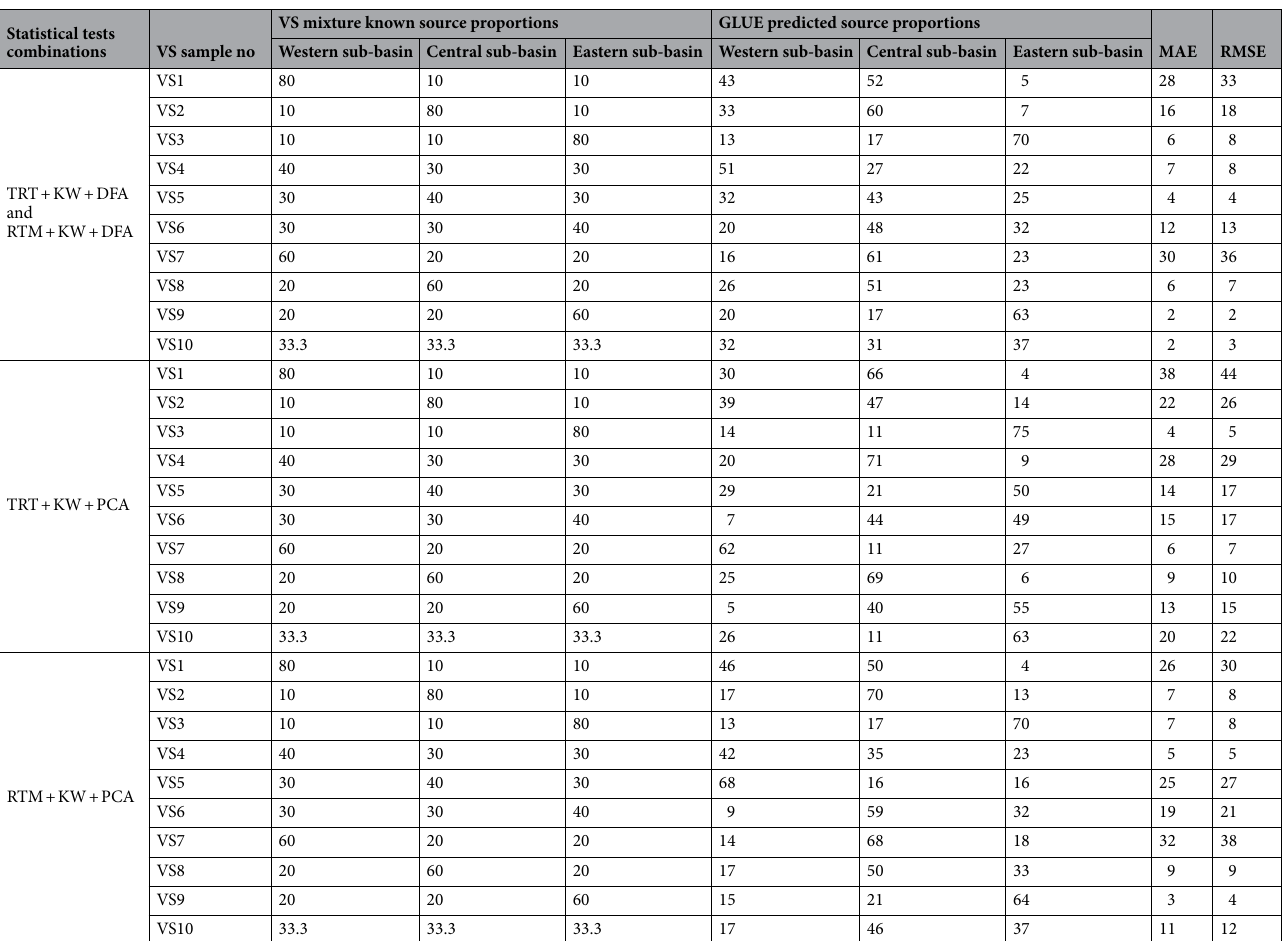
Table 5. Comparison of the modelled and known contributions from the three spatial sub-basin sources to the target sediment samples (VS1-VS10) using GLUE and virtual sediment (VS)